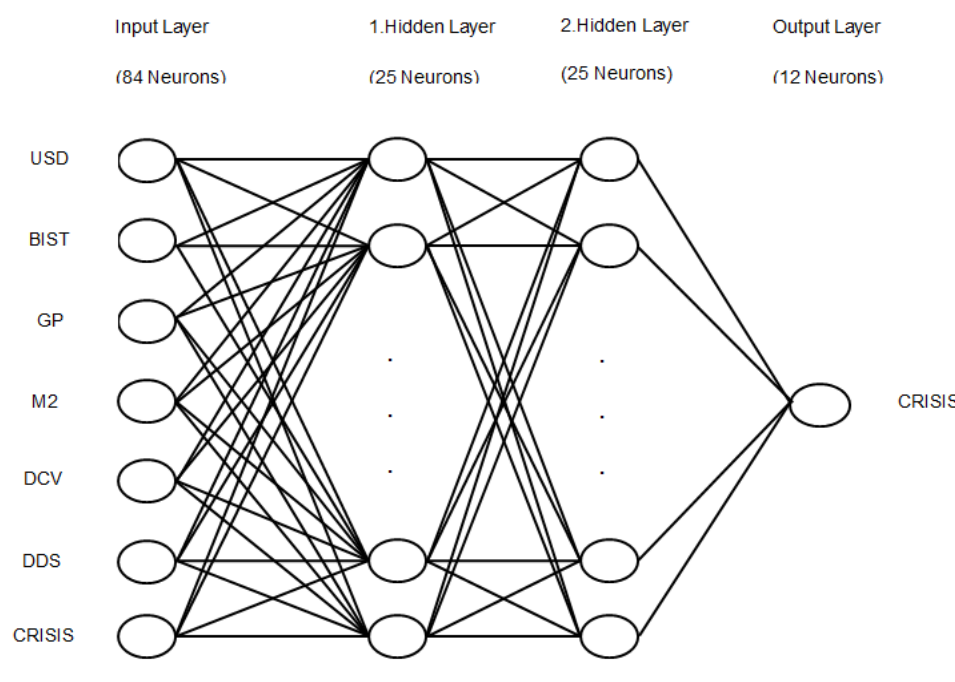
Figure 1. The depiction of the proposed methodology for the first ANN constituted with seven inputs and one